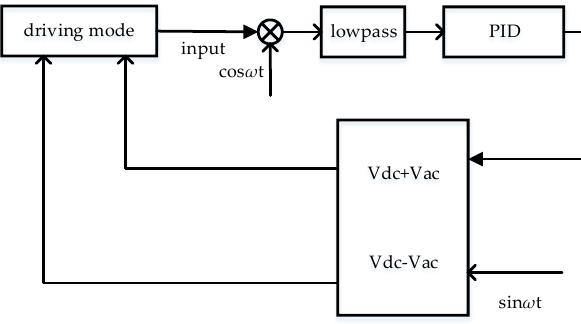
Figure 12. Amplitude control loop.